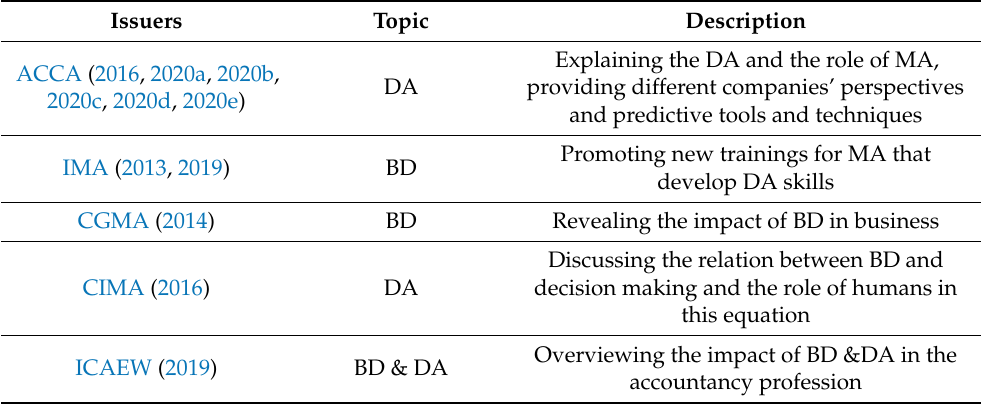
Table 1. Technical articles.